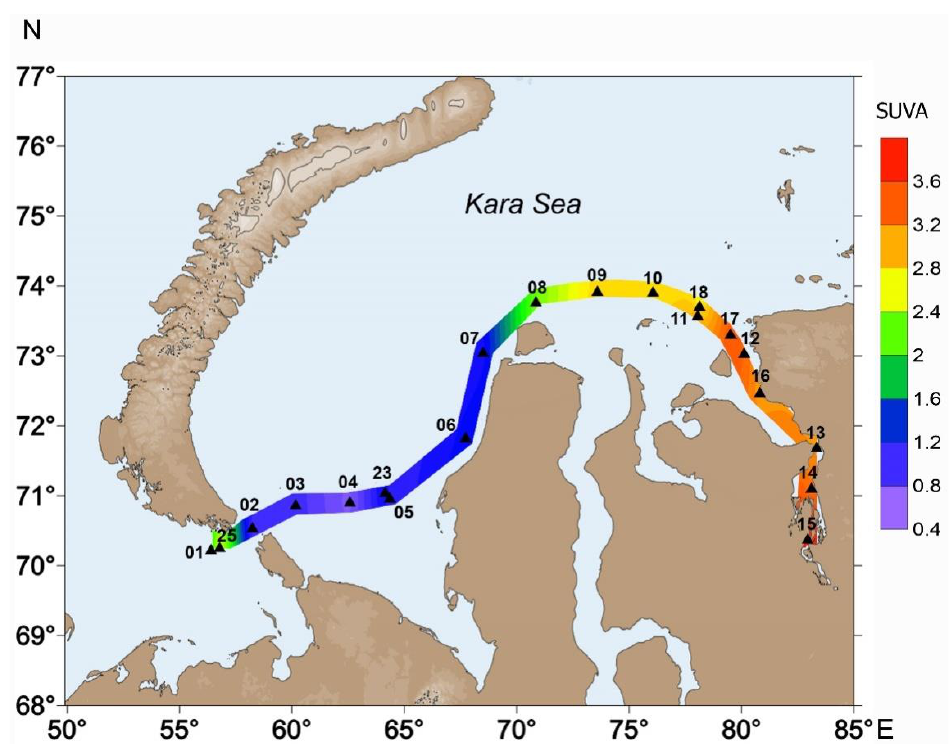
Figure 3. Variation of specific UV absorbance (SUVA, m 2 /gC) at stages 1 and 2. The surface water temperature in the MZ at stage one (end of June) ranged from −1 At stage two (mid-July) in the same area (stations 19 and 20), the salinity to +2.1 °C, while at stations three and four, located within a continuous ice field, the water